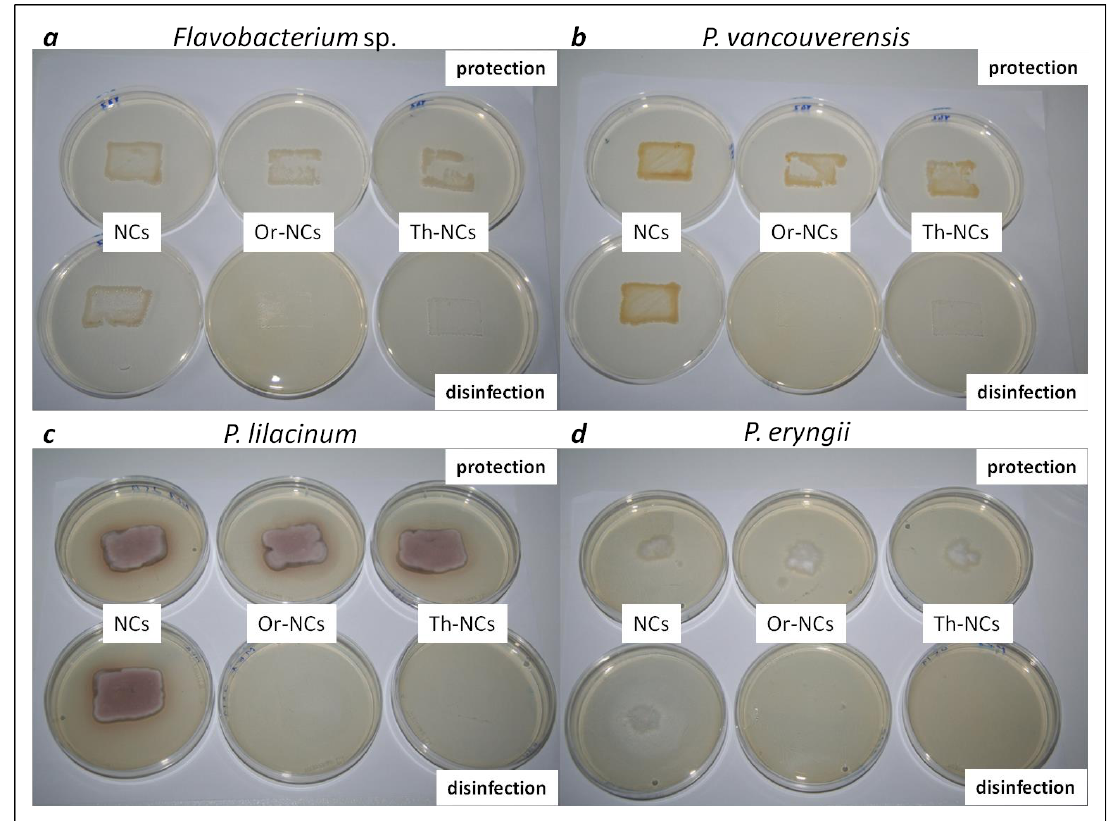
Figure 2. Microbial cultures transferred from the material surfaces treated with empty NCs and EOs-NCs (tested for their protection and disinfection effects) to Petri dishes, using the agar plate printing method. The pictures show bacteria and fungi biofilms, ( a ) Flavobacterium sp. (sandstone); ( b ) P. vancouverensis (sandstone); ( c ) P. lilacinum (sandstone); ( d ) P. eryngii (whitewood).